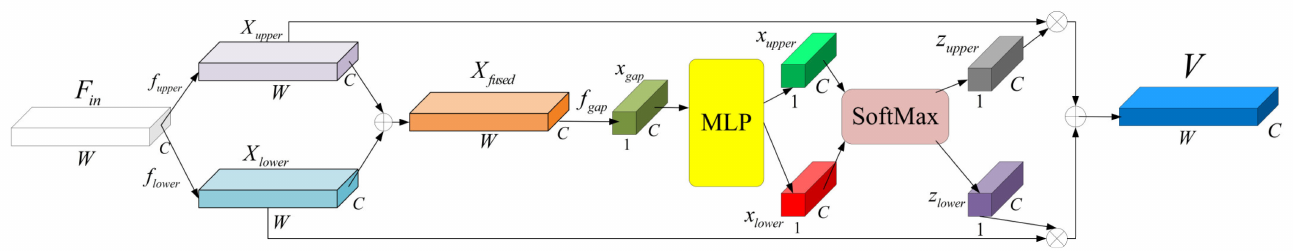
Figure 2. The structure of selective kernel convolutional